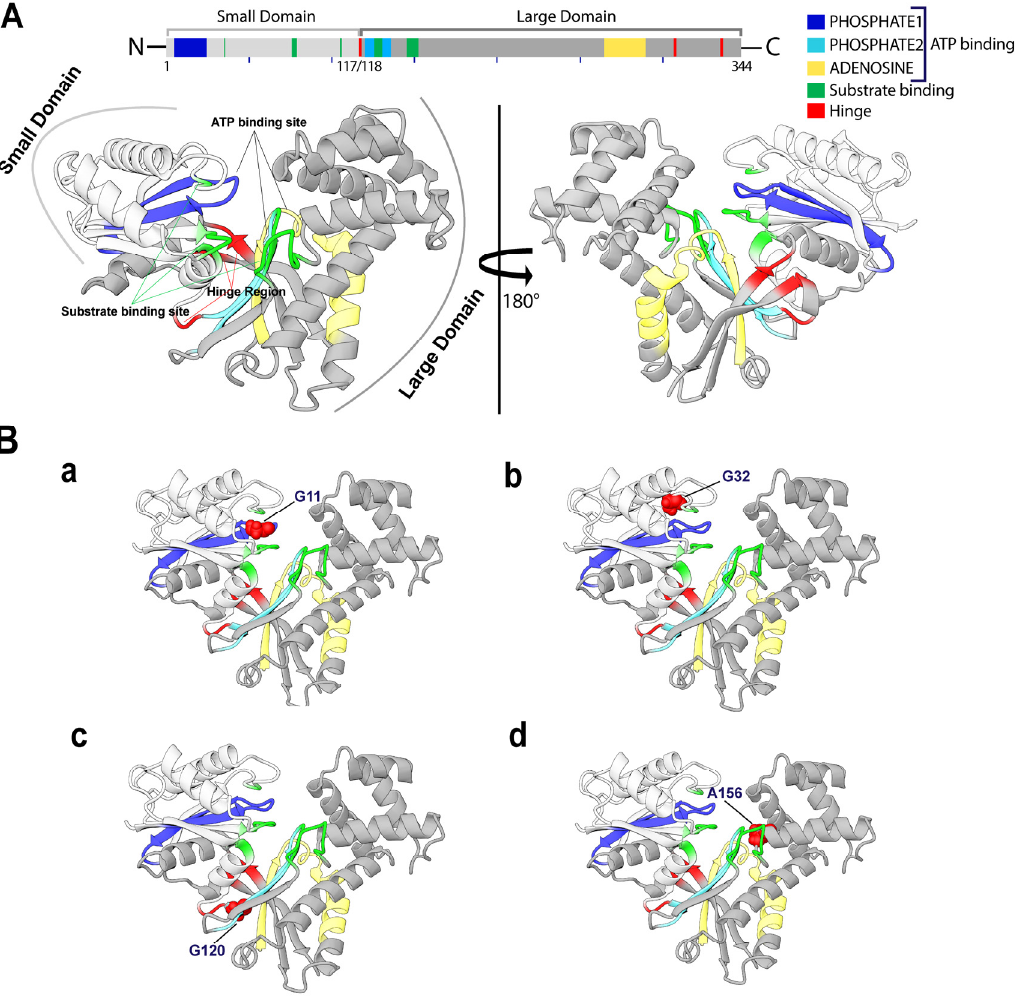
Figure 2. Molecular architecture in human NAGK crystal structure. ( A ) Representative three-dimensional structure highlighting the structural domains and motifs present in NAGK. ( B ) Cartoon representation labeled with identified variant position for G11R ( a ), G32R ( b ), G120E ( c ), and A156D ( d ).